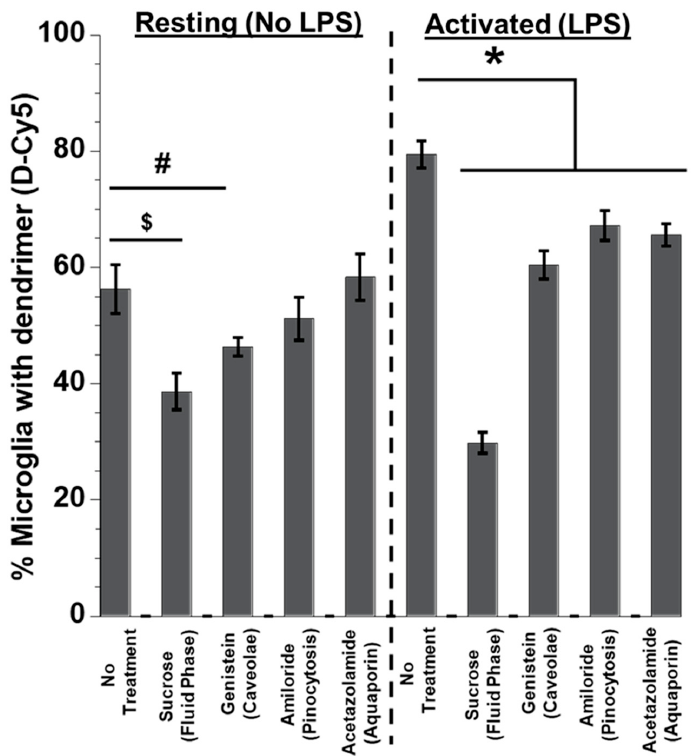
Figure 7. Evaluation of dendrimer uptake using flow cytometry after treatment with various cell entry pathway inhibitors. The mixed glial cultures were activated with LPS, various cell entry pathways were blocked using inhibitors, and the D-Cy5 uptake changes were evaluated using flow cytometry. D-Cy5 uptake was significantly reduced after blocking different endocytosis pathways (fluid phase and Caveolae-mediated endocytosis), suggesting that the cell entry of dendrimer majorly happens via endocytosis. In the case of LPS-activated cell population, D-Cy5 uptake was significantly inhibited when pinocytosis, aquaporin, and mannose pathways were blocked, suggesting that dendrimers may employ multiple pathways for cell entry in activated microglia. All the values are represented as mean ± SEM, n = 4, $ t -test, p <0 .01, and # t -test p < 0.001. * Two-way ANOVA, p < 0.001 (no-LPS or LPS treated (Resting or Activated) no inhibitors (no treatment) (vs.) no-LPS or LPS-treated (resting or activated) with inhibitors).